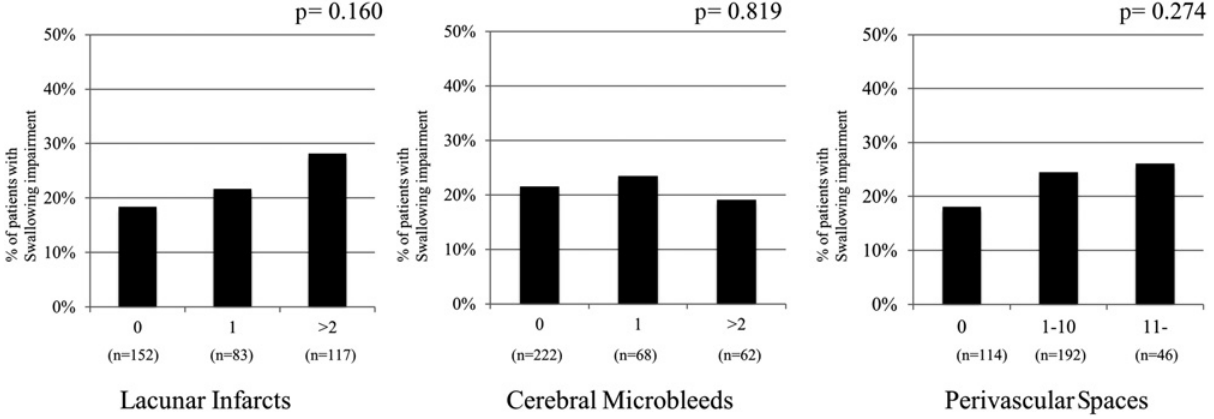
F i g ure 3 Relation of d y spha g ia and lac u nar infarcts (LI), cerebral microbleeds (CMBs) and peri v as- c u lar spaces ( PV